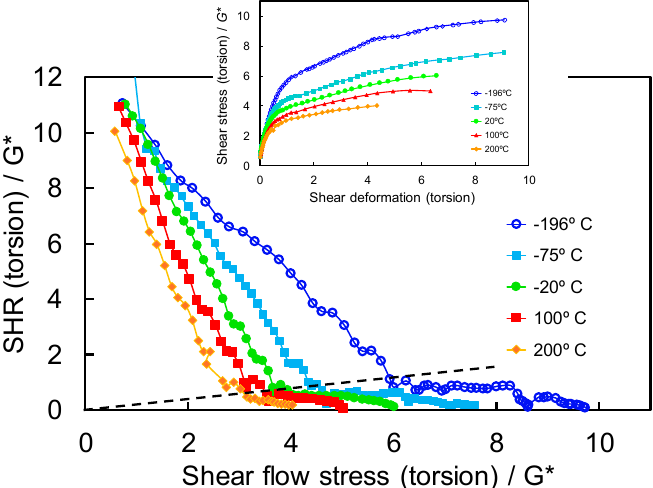
Figure 3. Shear strain-hardening rate vs. shear flow stress in torsion of 99.98% Cu (77, 198, 293, 373, and 473 K) deformed at a Von Mises equivalent (VME) strain rate (cid:2013)̅(cid:4662) = 8 × 10 − 3 s − 1 . The inset shows the shear strain vs. shear flow stress curves. Replotted from Alberdi [11].